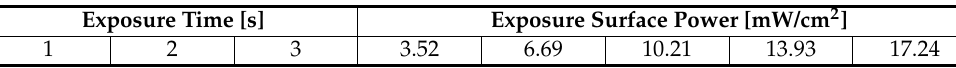
Table 3. Curing parameters